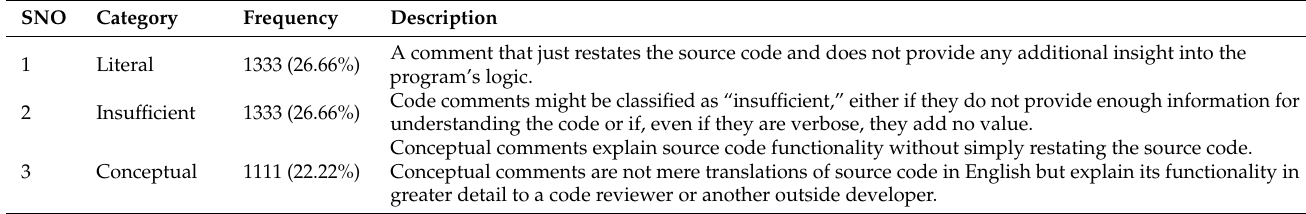
Table 4. Taxonomy and annotation with new